Question: Compose a caption that would accompany this figure in a paper.
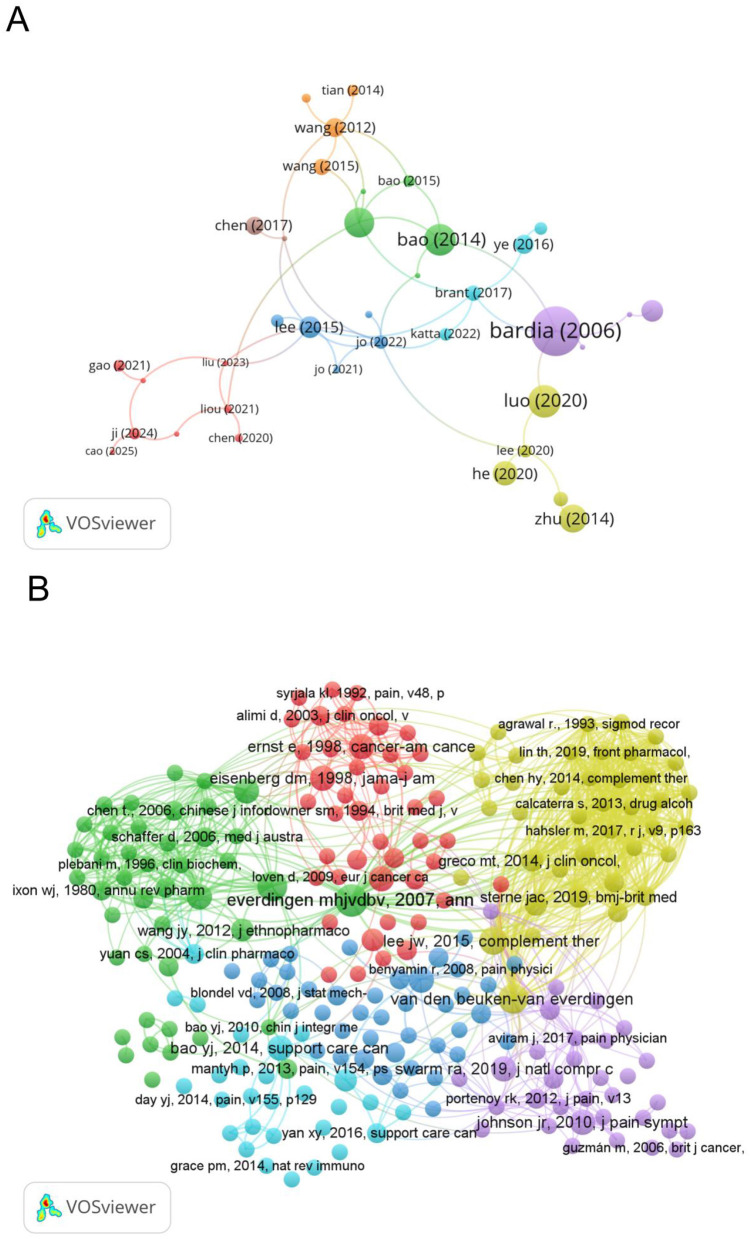
Answer: Citation and co-citation analysis of references. (A) Network visualization of reference citation. Each node represents a cited publication, with node size reflecting citation frequency. Links indicate citation relationships among publications. (B) Network visualization of co-cited references. Each node represents a co-cited reference, and links indicate co-citation relationships. Different colors represent clusters of references that constitute major knowledge domains within the field.